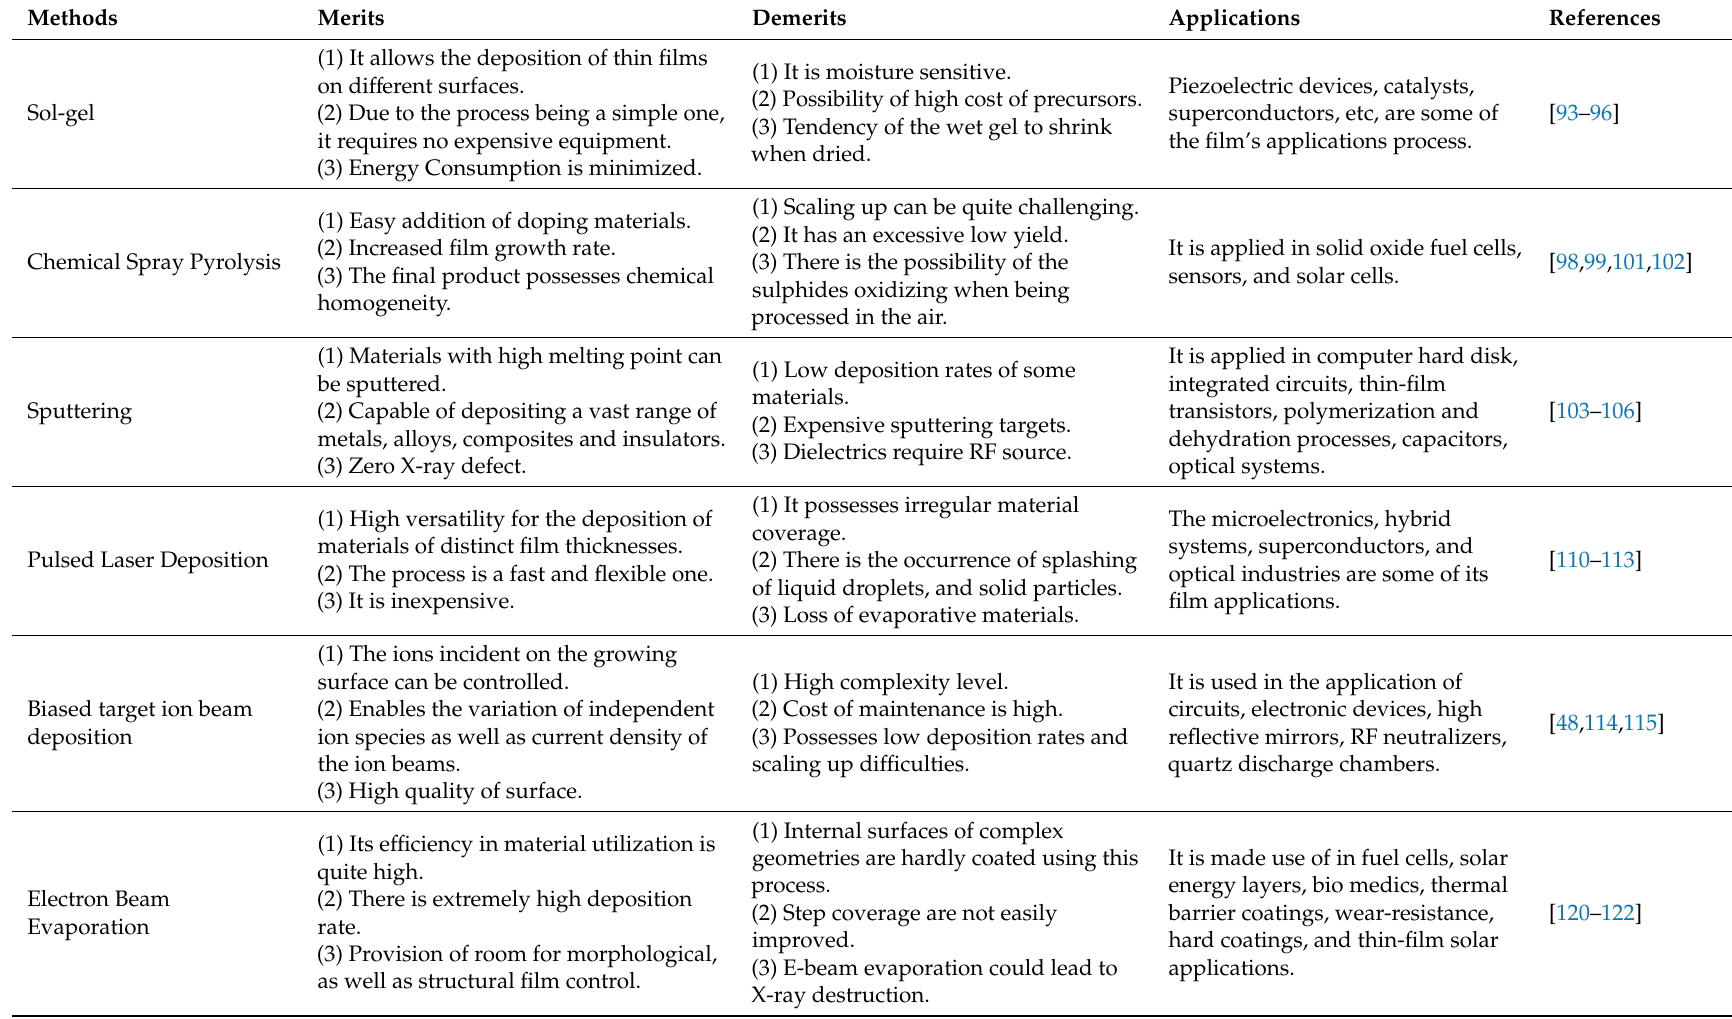
Table 2. Merits, Demerits, and Applications of the Di ff erent Deposition